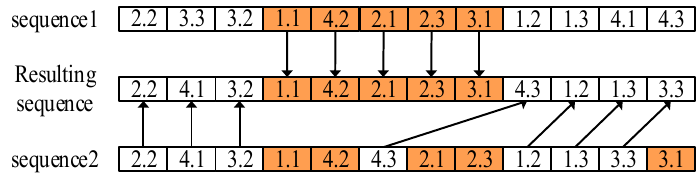
Figure 4. Order crossover operator for the production sequence. Algorithm 6 The procedure of the improved acceptance criterion. Algorithm 6 The procedure of the improved acceptance